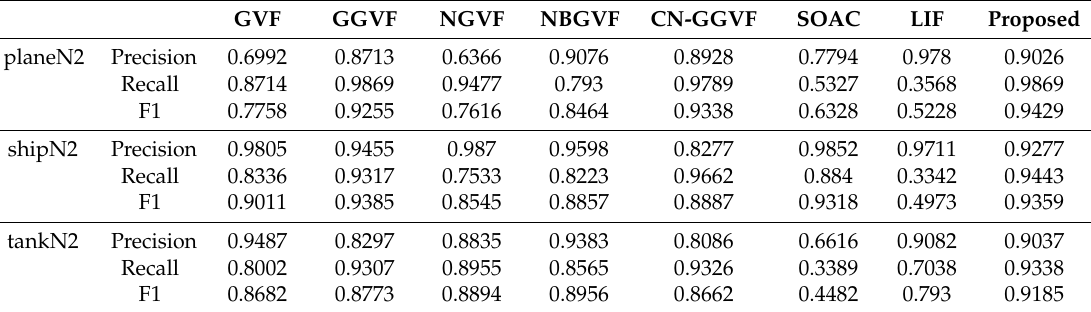
Table 3. The comparison of Quantitative evaluation results on infrared images corrupted with multiplicative noise.